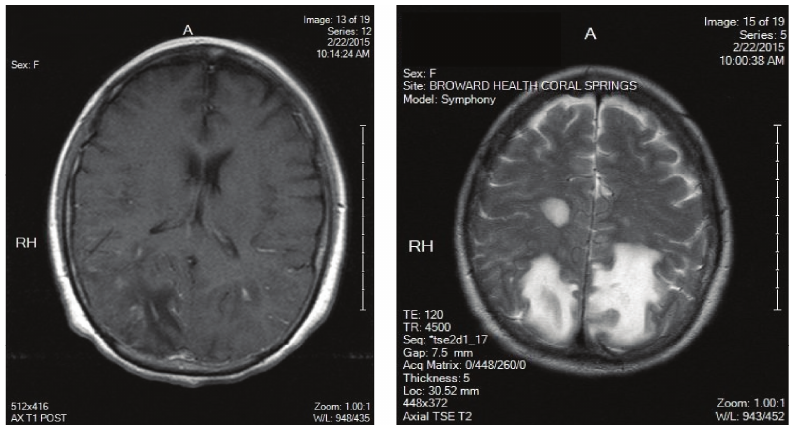
Figure 1: Brain MRI on admission: multiple enhancing masses in the bilateral occipital and posterior parietal lobes on T1 and T2. Enhancement in the right centrum semiovale is also visualized.